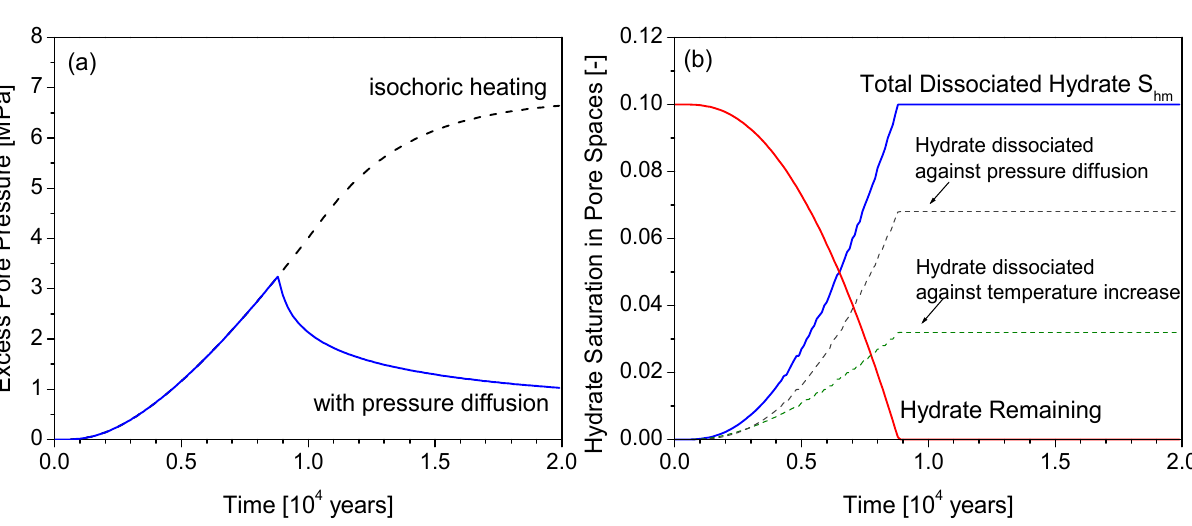
Figure 6. ( a ) Excess pore pressure developed, ( b ) volume fractions of remaining and dissociated gas hydrates and volume fractions of dissociated gas hydrates against temperature increase and pressure diffusion at the